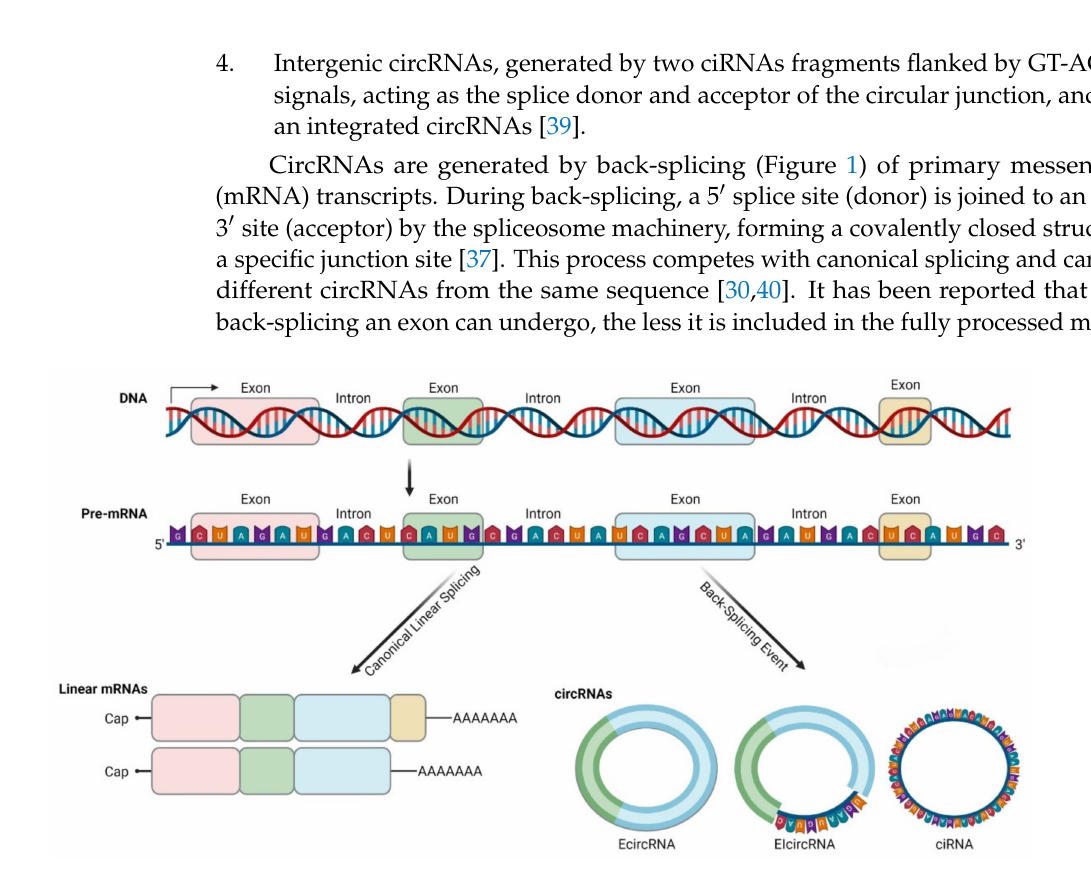
Figure 1. Biogenesis and diversity of circRNAs. CircRNAs are produced by exon-skipping or another non-canonical event (like back-splicing) that can initiate internal splicing. CircRNAs are present in blood, body fluids and tissues, and can serve as potential disease biomarkers. They are non-polyadenylated, unlike mRNAs, and they are covalently closed. CircRNAs are resistant to exonucleases digestion due to their lack of 5 (cid:48) or 3 (cid:48) end. CircRNAs can be exonic, intronic or a combination of both (this illustration was created with BioRender.com, accessed on 3 November